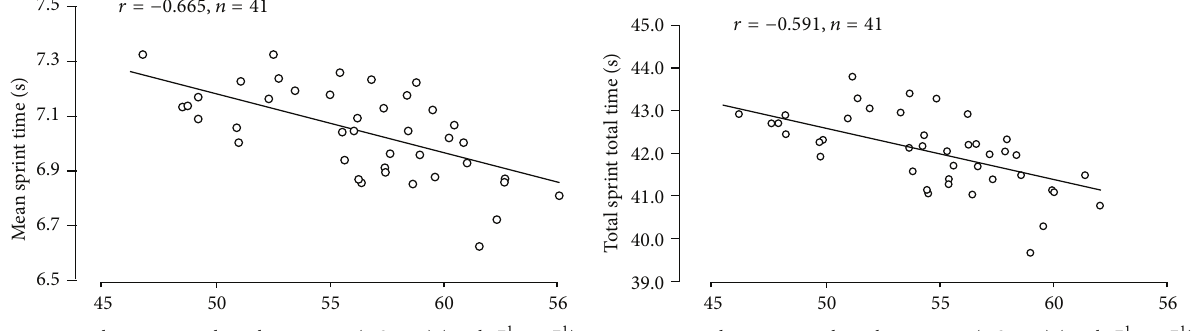
Figure 1: Relationship between relative aerobic capacity and mean sprint time (a) and total sprint time (b).